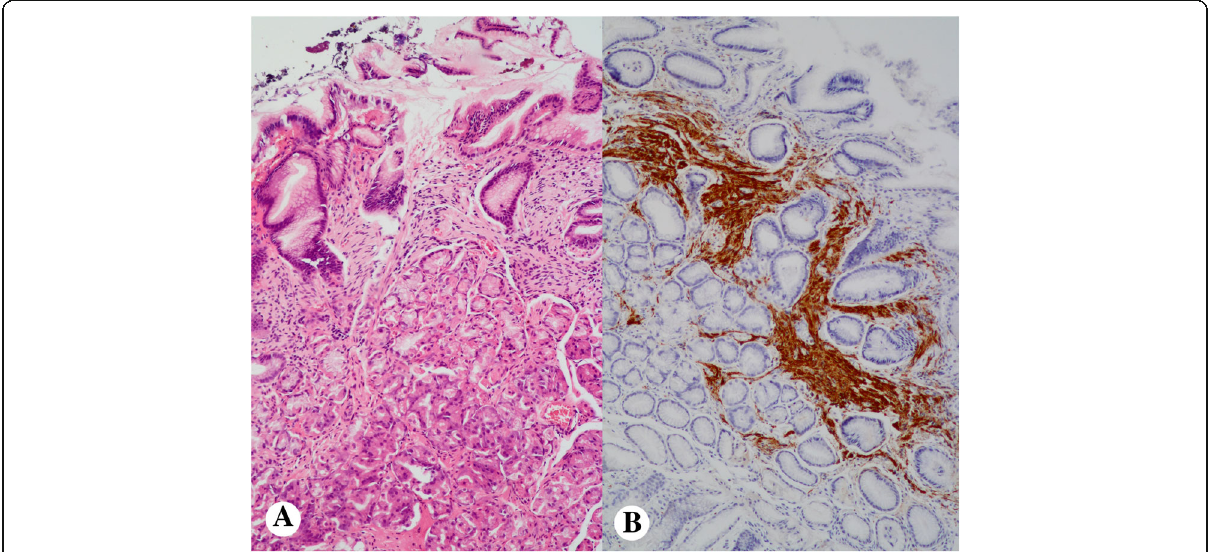
Fig. 2 Case 2. Mucosal Schwann cell hamartoma in the gastric mucosa. A poorly circumscribed spindle cell lesion permeating gastric glands. Hematoxylin-eosin sections a 100x magnification. Strong and diffuse immunohistochemical staining for S100 protein (100x magnification) ( b